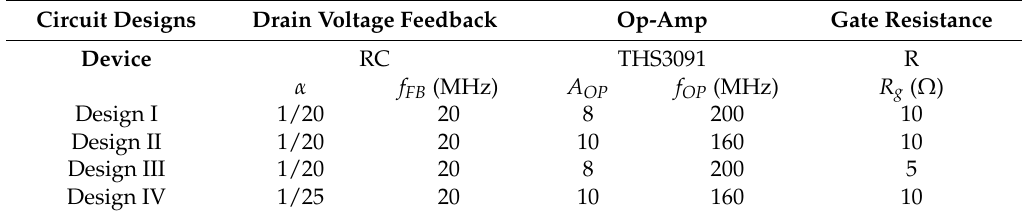
Table 1. Designs of the closed-loop gate drive circuit.